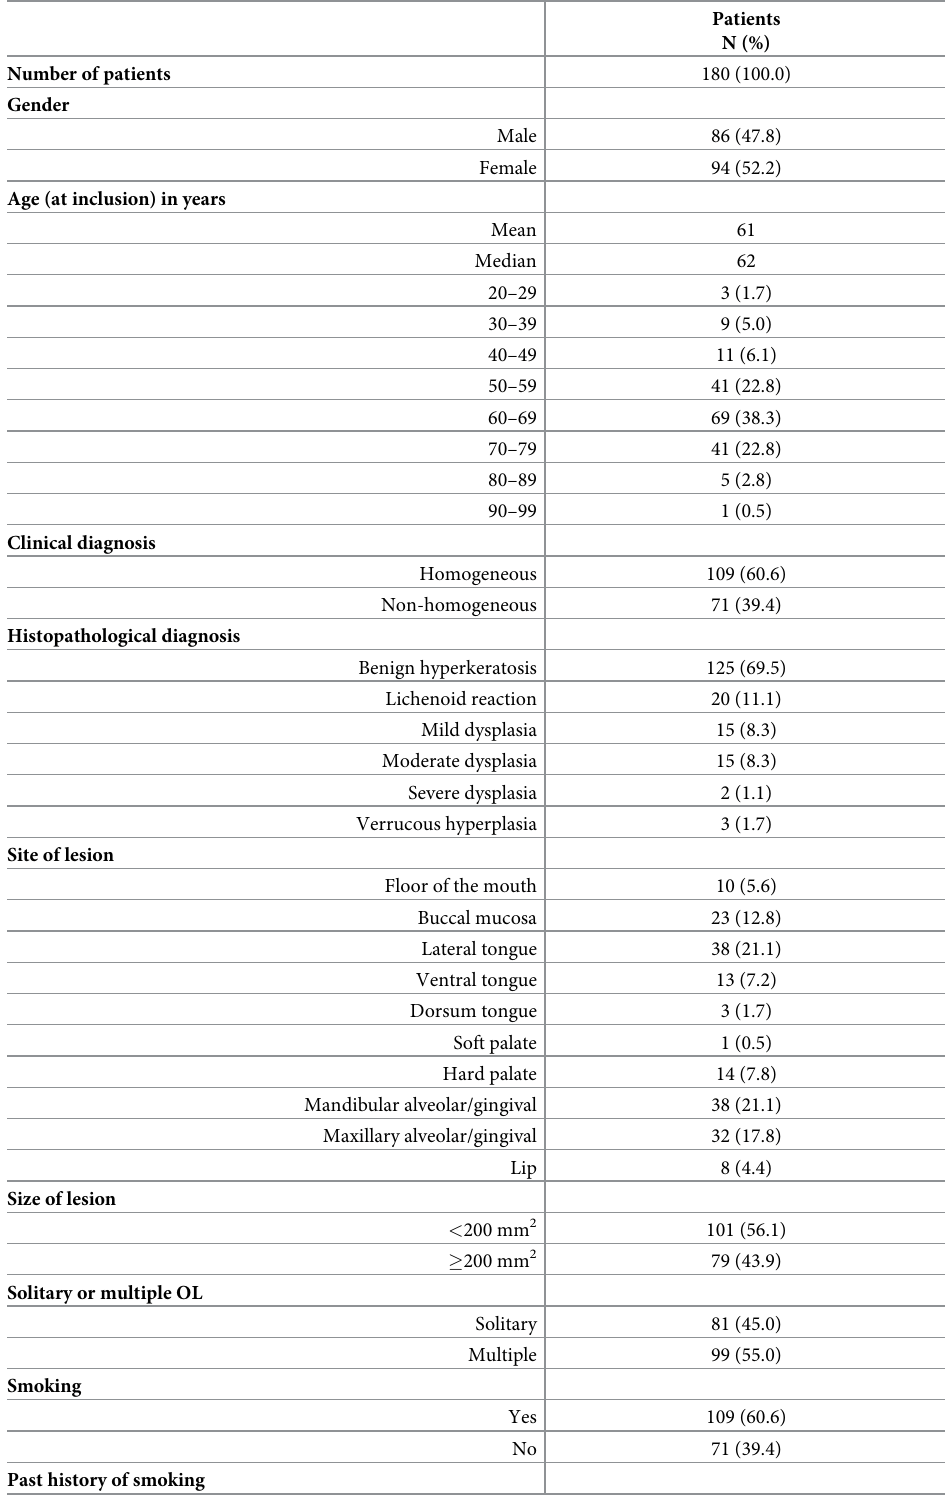
Table 1. Patients’